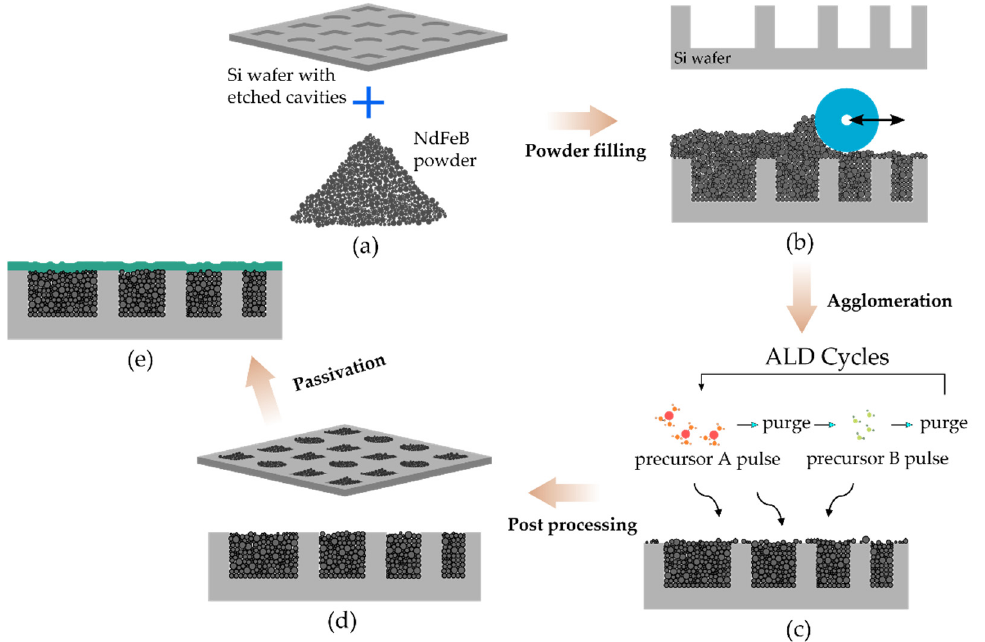
Figure 2. Schematic image depicting the process flow for fabricating ALD-solidified NdFeB micromagnets. ( a ) Etching of cavities of different shapes and sizes into a silicon wafer using DRIE. ( b ) Filling of dry NdFeB powder into pre-etched cavities. ( c ) Deposition of ALD layer to fixate the loose particles. ( d ) Post-processing of substrate wafer. ( e ) Passivation of the fabricated structures with SiO 2 layer deposited by PECVD.